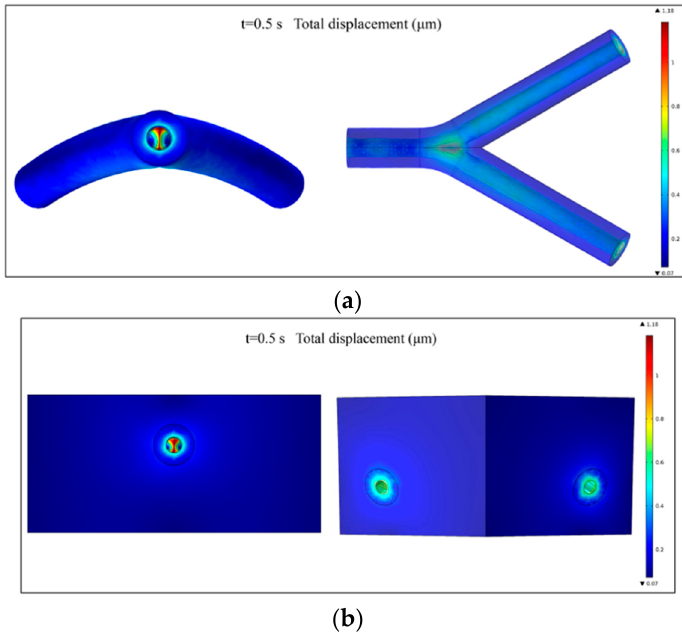
Figure 6. ( a ) The total displacement of the TEVG at the peak load (t = 0.5 s); and ( b ) the total displacement of the whole construct at the peak load (t = 0.5 s).